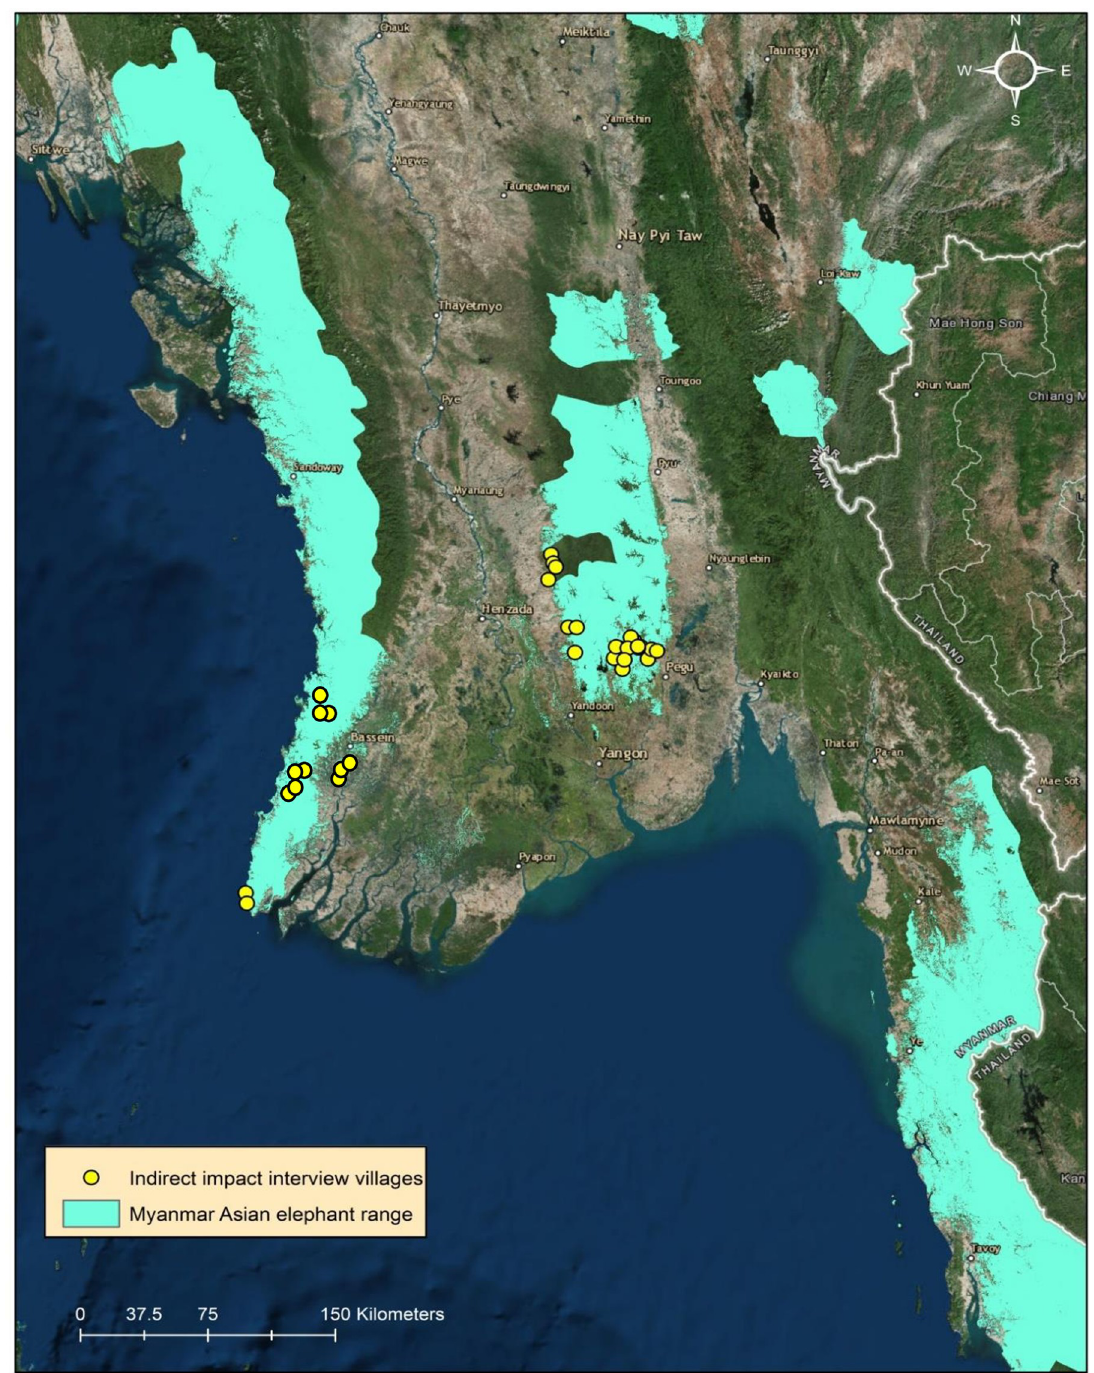
Fig 1. Locations of study sites in Myanmar. Dots indicate villages where interview surveys were conducted (May 2017-December 2018). Image source: World Imagery: Ersi, DigitalGlobe, Earthstar Geographics, CNES/Airbus DS. GeoEye, USDA FSA, USGS, Getmapping, Aerogrid, IGN, IGP, and the GIS User Community (accessed November